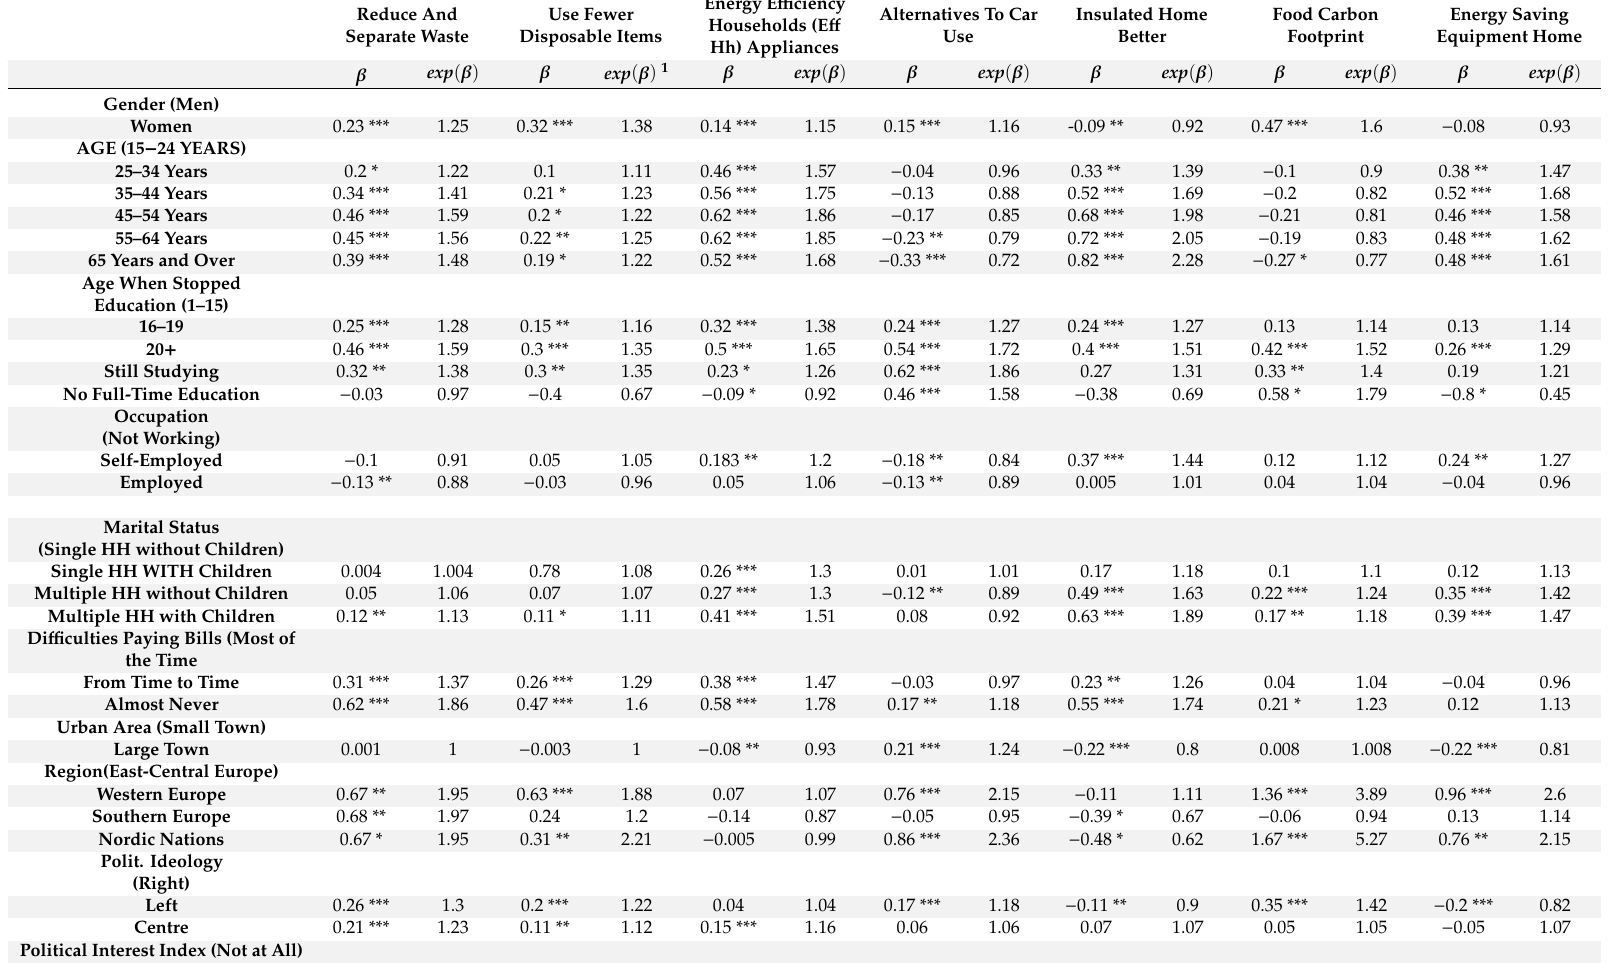
Table A3. Multilevel mixed-e ff ects logistic regression of climate change mitigation actions among European Union (EU)